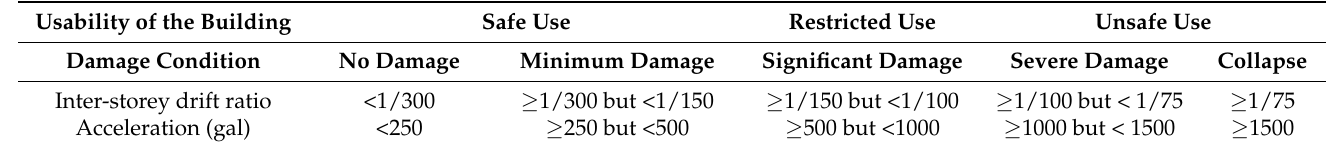
Table 1. Damage conditions from the structural responses [20].